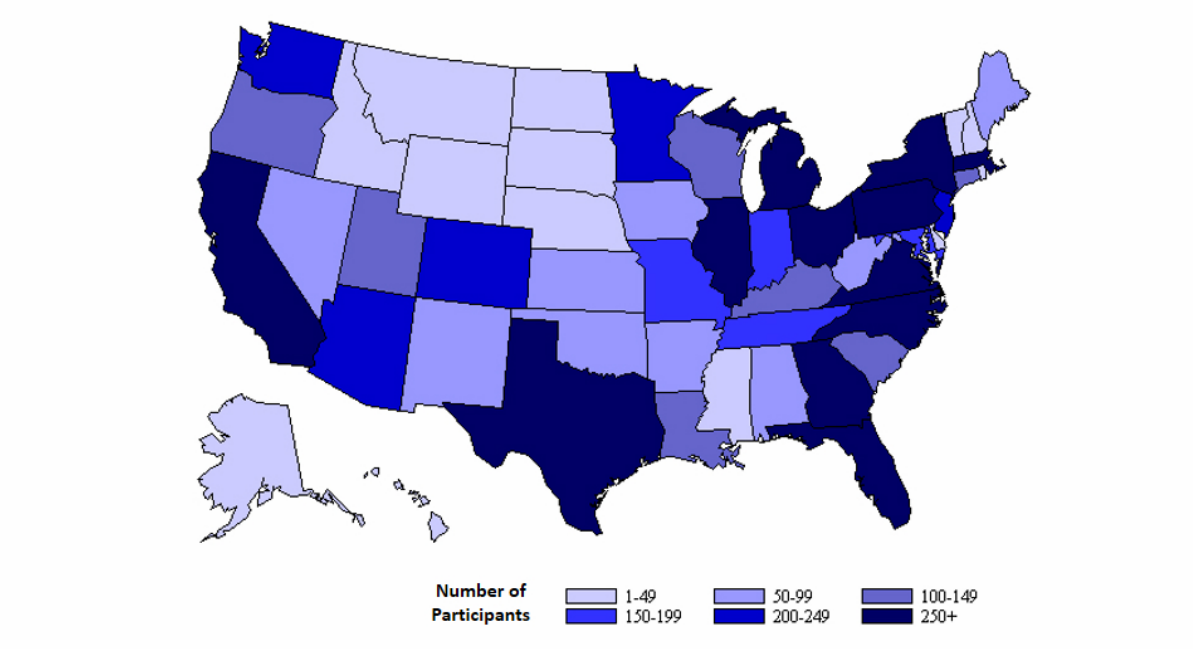
Figure 2. Number of MSM Participants in the American Men’s Internet Survey by State,